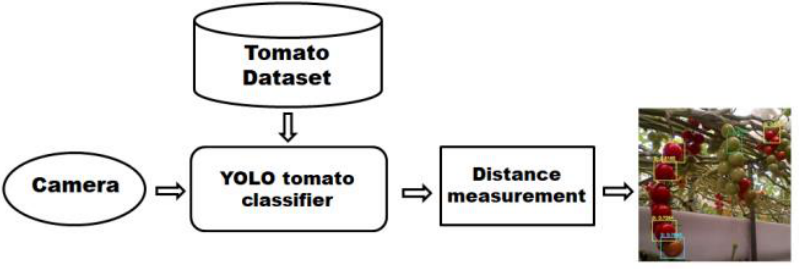
Figure 14. Tomato detection architecture.